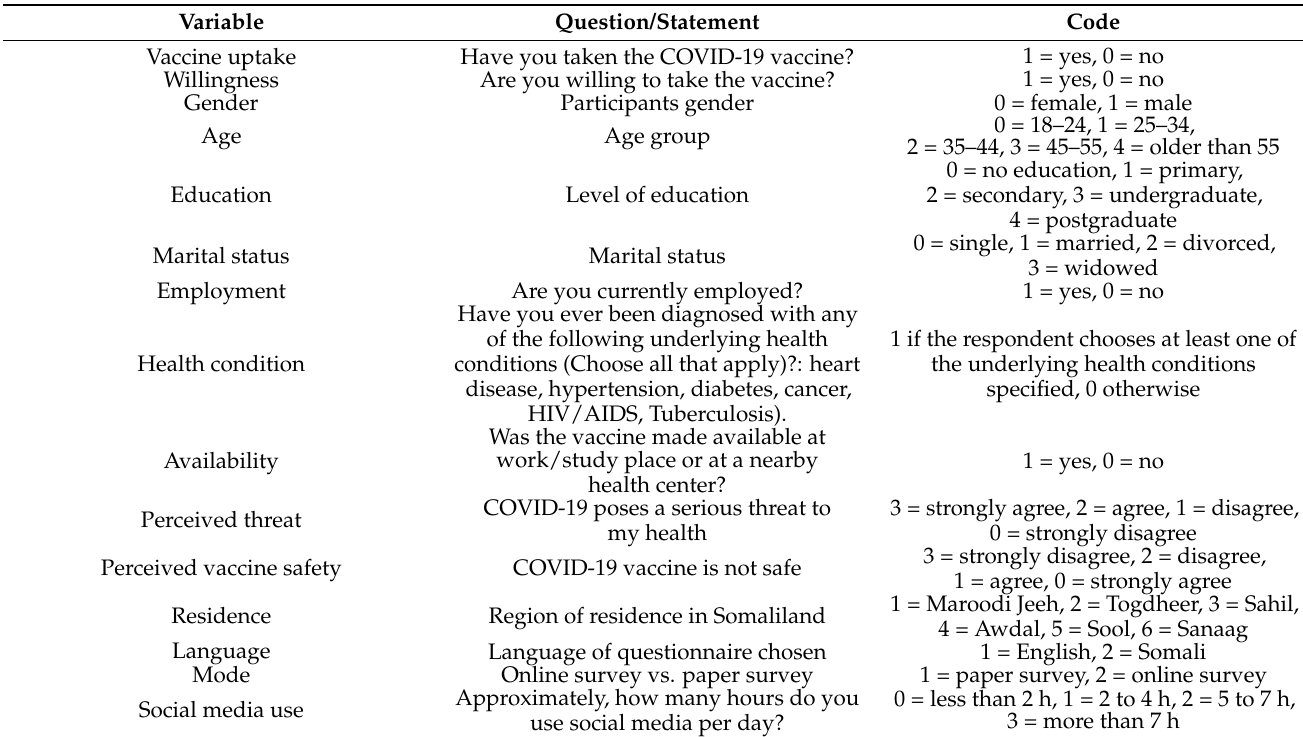
Table A1. Measurement of